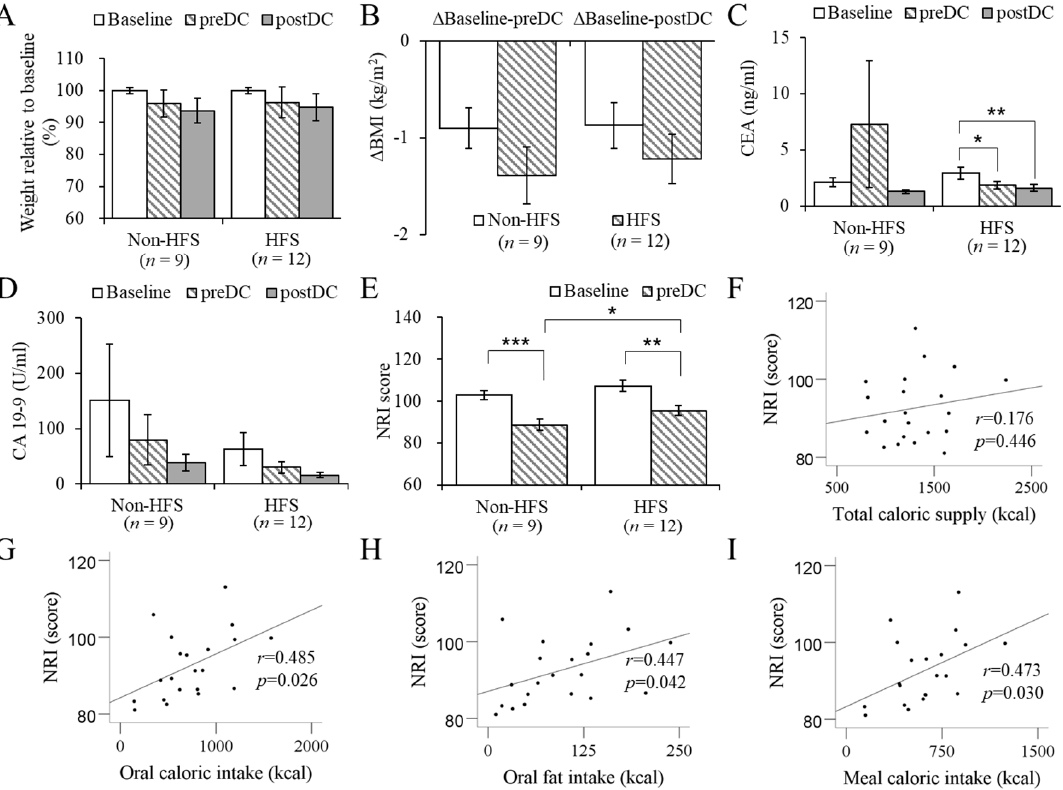
Figure 2. Changes in body weight, pancreatic blood biomarkers, and nutritional risk index (NRI) and the correlations between NRI scores and oral intakes of postoperative pancreatic cancer patients. ( A– B ) Body weight (ANOVA) and weight percentage relative to baseline (paired t -test) compared